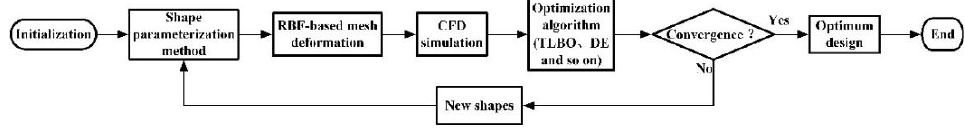
Figure A9. Direct optimization framework.